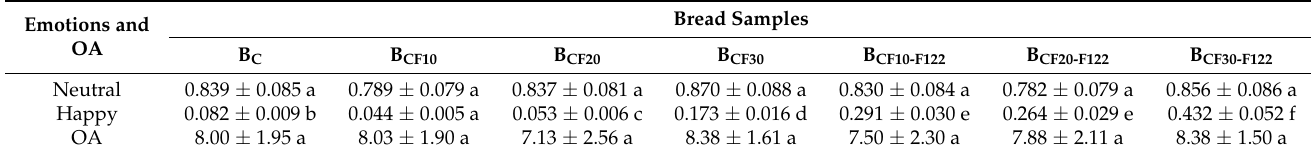
Table 7. Bread overall acceptability (OA) and induced emotions in trained judges. Bread Samples